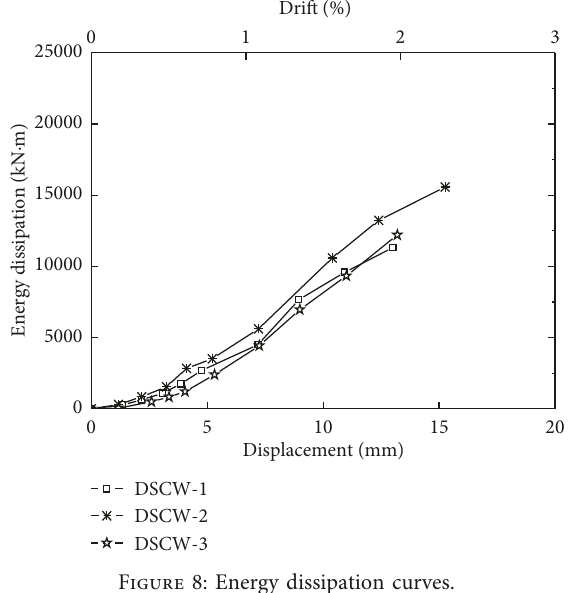
Figure 8: Energy dissipation curves.